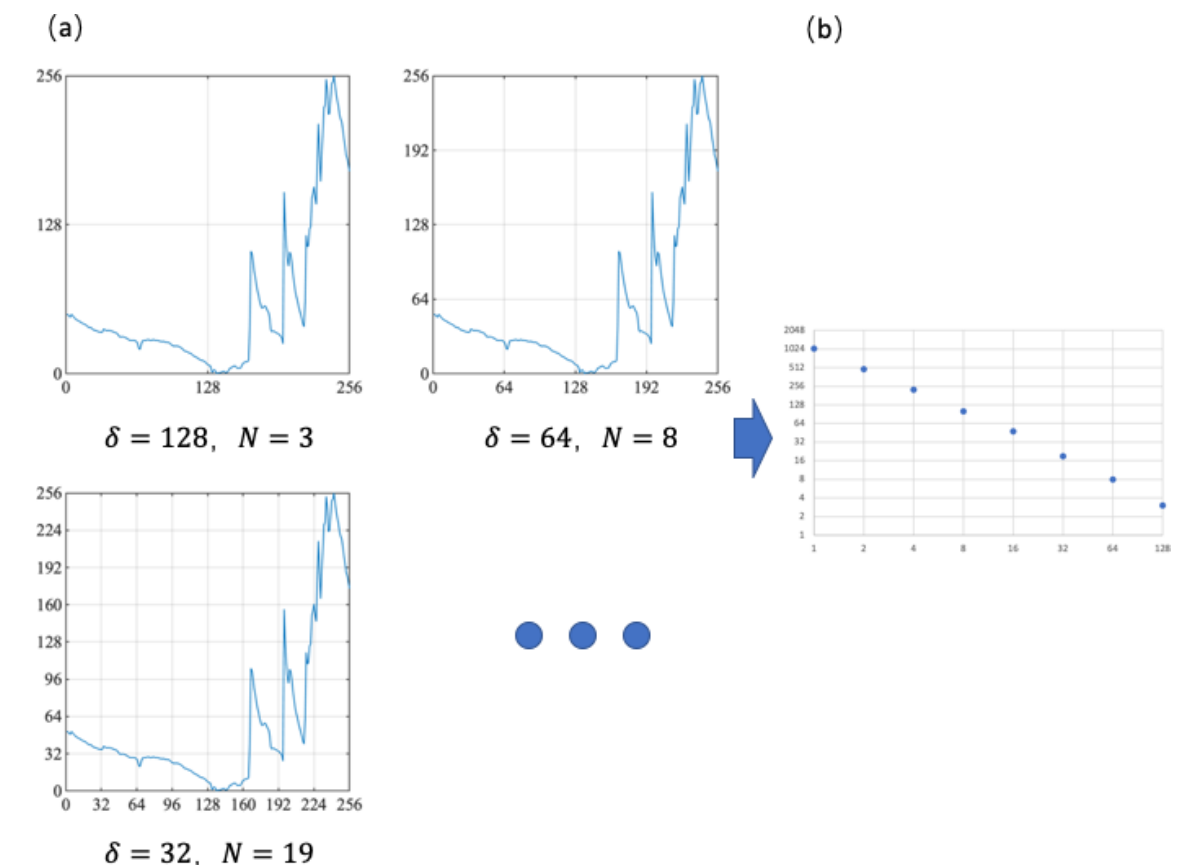
Figure 1. Flow chart for the use of the box-counting method to calculate the Hausdorff dimension of a time series.